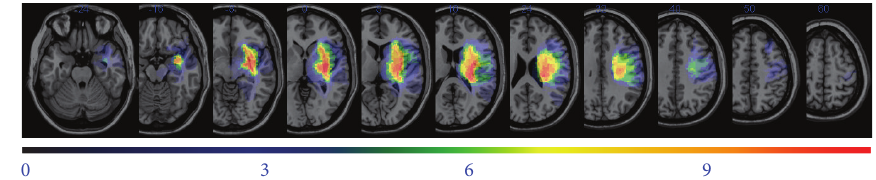
Figure 1: Overlay of lesions for patients with hemorrhagic stroke. Voxels damaged in 1 patient are shown in purple and shades toward the red end of spectrum denote voxels where larger numbers of patients were lesioned.